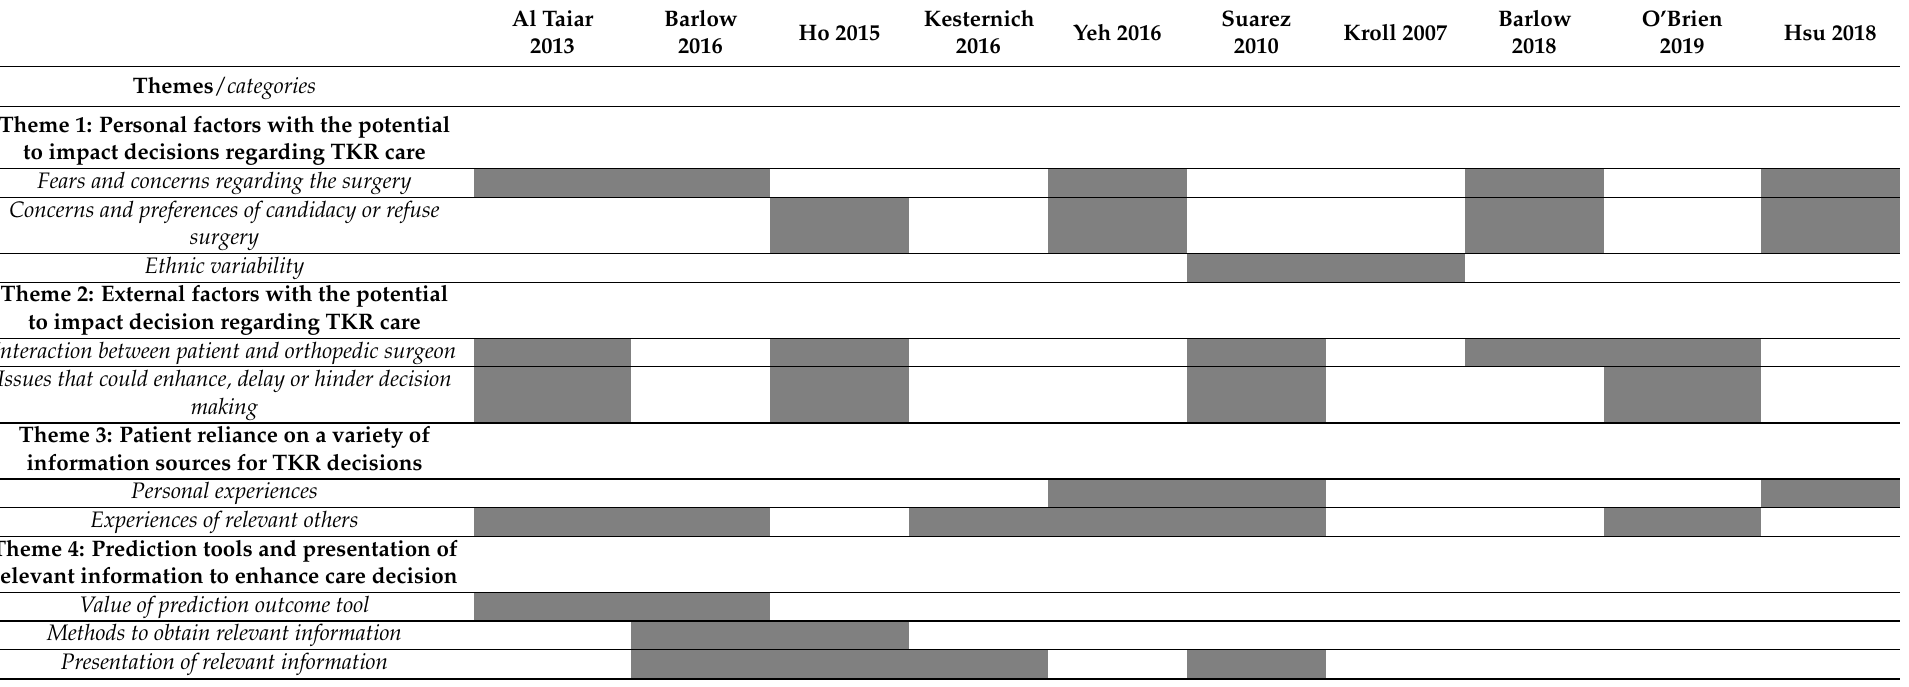
Table 3. Themes and categories relevant to patients for participating in a SDM process around total knee replacement